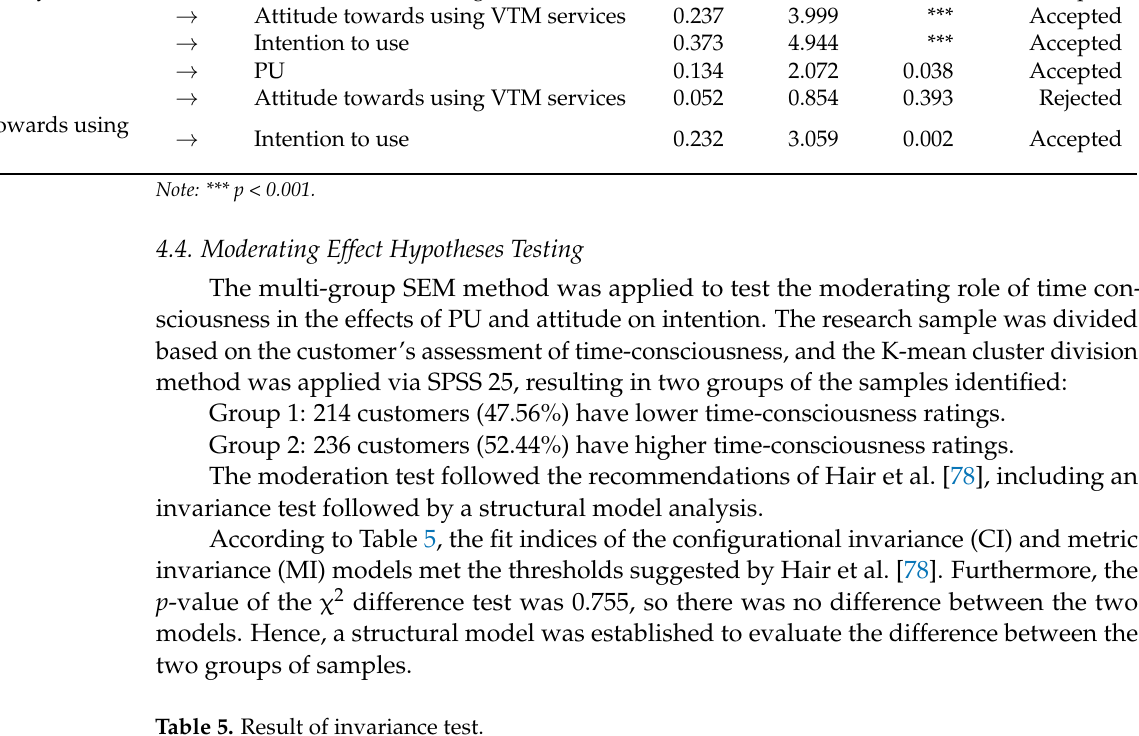
Table 5. Result of invariance